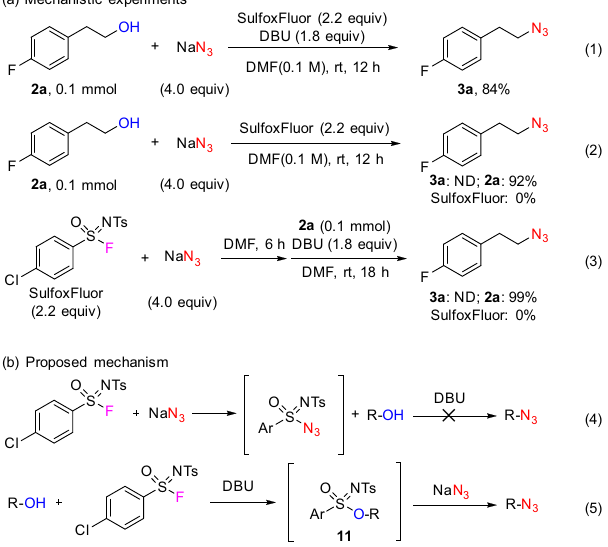
Fig. 3 Synthetic applications. a Gram-scale synthesis of alkyl azide 3ai and its further elaboration via Click reaction. b One-pot deoxyazidation and subsequent Click reaction. Conditions A: CuSO 4 (cid:129) 5H 2 O (1 mol%), sodium ascorbate (10 mol%), t BuOH/H 2 O = 1:1, rt, 24 h.